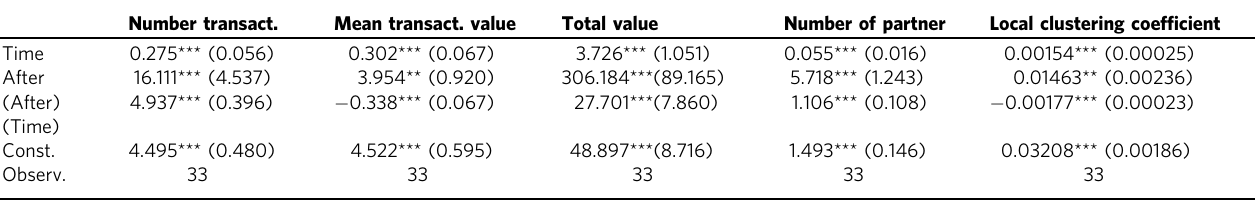
Table 6. Number of transactions, average transaction, total of dollars exchange, number of partners and degree to tend to cluster — 90-day spans.